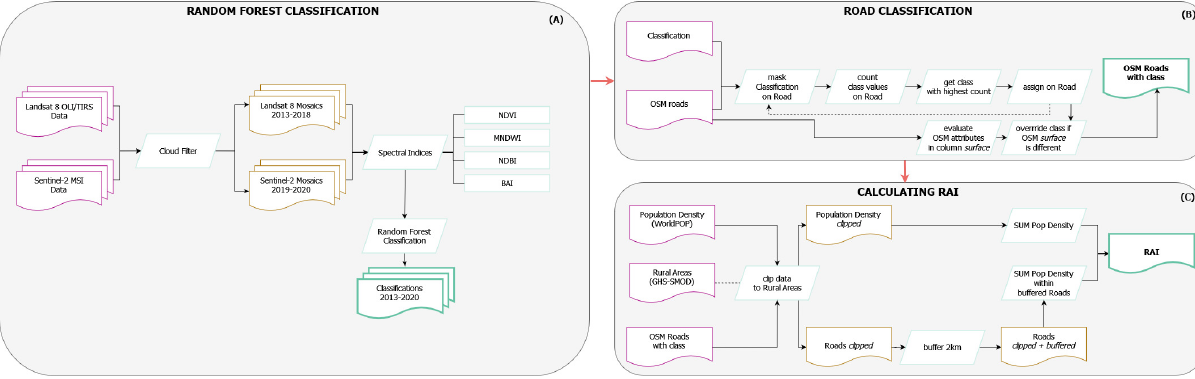
Figure 2. Schematic